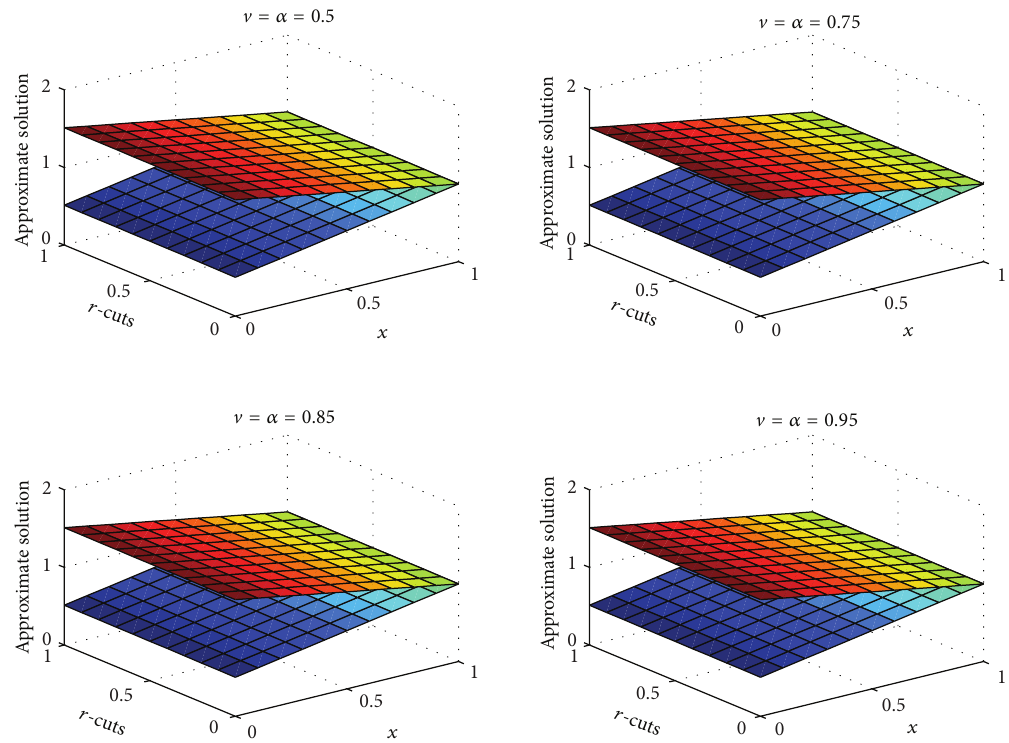
Figure 7: The fuzzy approximate solution for different values of fractional orders V = 𝛼 with 𝑚 = 8 , 𝑘 1 = 0.012 , and 𝑘 2 = 0.001 .